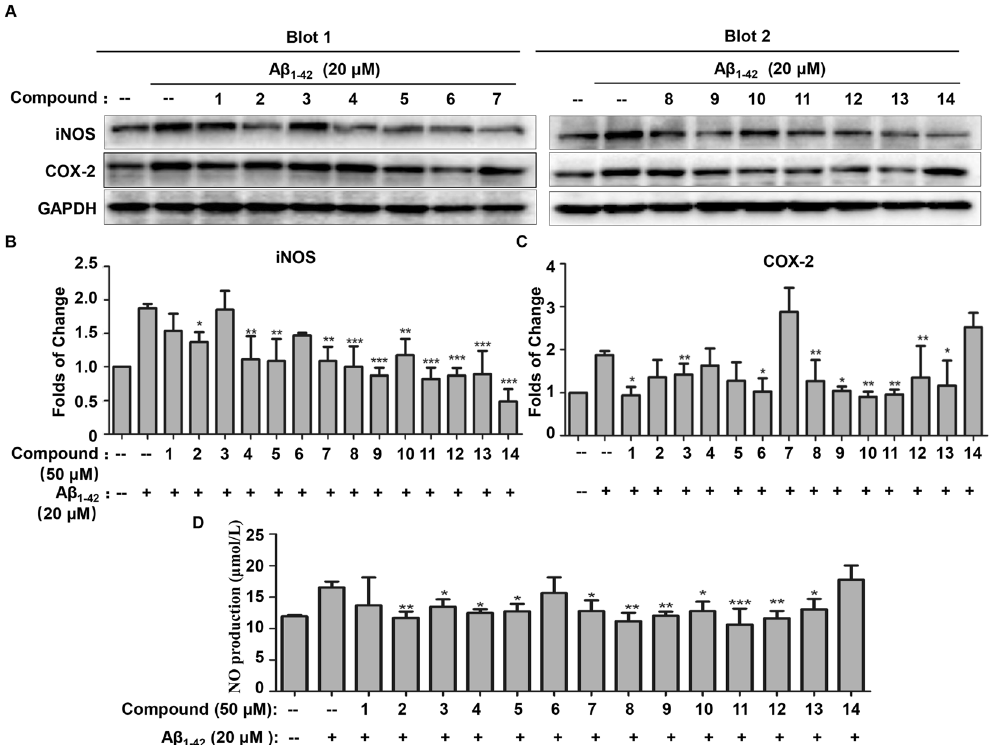
Figure 7. Effects of isolated compounds on iNOS, COX-2 expression and NO production in A β 1–42 -treated BV2 microglia cells. ( A ) Western blot analysis of iNOS and COX-2 expression. The cells were pre-treated with all compounds (50 μ M) for 1 h, and subsequently incubated with 20 μ M of A β 1–42 for 24 h. The expression of iNOS and COX-2 was detected by Western blotting and quantified by Image Lab software. ( B and C ) Quantification of iNOS and COX-2 induction (Panel A). Data were expressed as mean ± SD (n = 3) and analyzed by one-way ANOVA with Dunnett’s test for iNOS expression and LSD test for COX-2 expression. * p < 0.05; ** p < 0.01; *** p < 0.001. (Drug plus A β 1–42 vs A β 1–42 ). ( D ) Determination of NO production in A β 1–42 -treated BV2 microglia cells. BV2 cells were pretreated with all compounds (50 μ M) for 1 h, and then stimulated with A β 1–42 (20 μ M) for 6 h, the culture medium was collected for measurement of NO production by using Griess reagent kit for nitrite determination. Data were expressed as mean ± SD (n = 3) and analyzed by one-way ANOVA